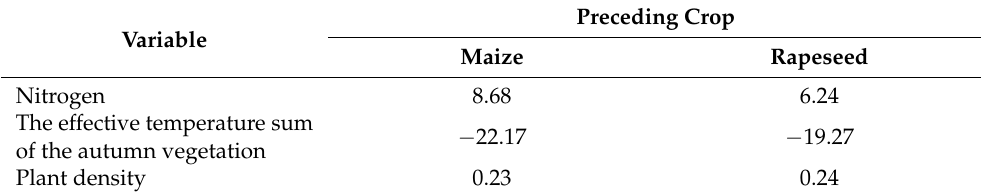
Figure 3. Yield versus plant density. Table 3. The slope of a linear function .